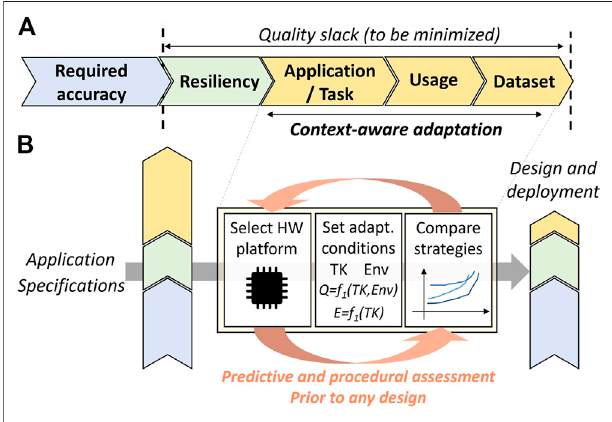
FIGURE 1 | (A) The concept of quality slack, adapted from the work of Alioto (2017), and (B) overview of the proposed methodology.